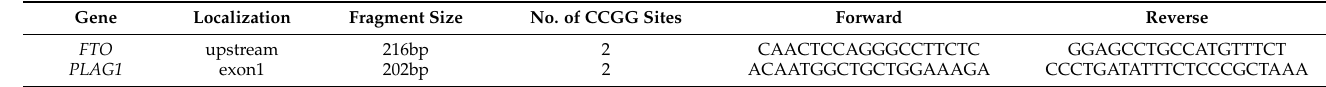
Table 1. Sequences of primers used for the qPCR